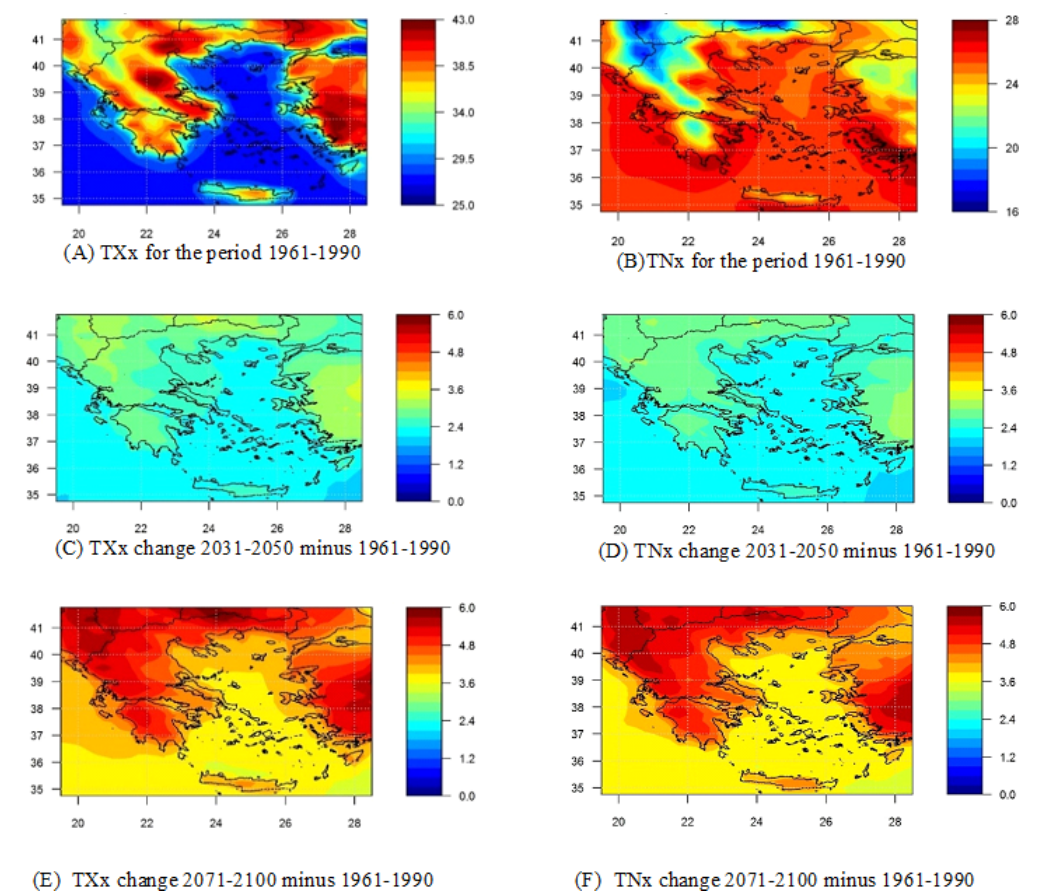
Figure 4. Spatial distribution of ensemble means of maximum daily maximum temperature ( T X x ) (a, c, e) and maximum daily minimum temperature ( T N x ) (b, d, f) for the reference period (a, b) , along with changes of near future (c, d) and far future (e, f) from the reference period. The color scale concerns degrees Celsius ( ◦ C) (adapted from Nastos and Kaposmenakis,